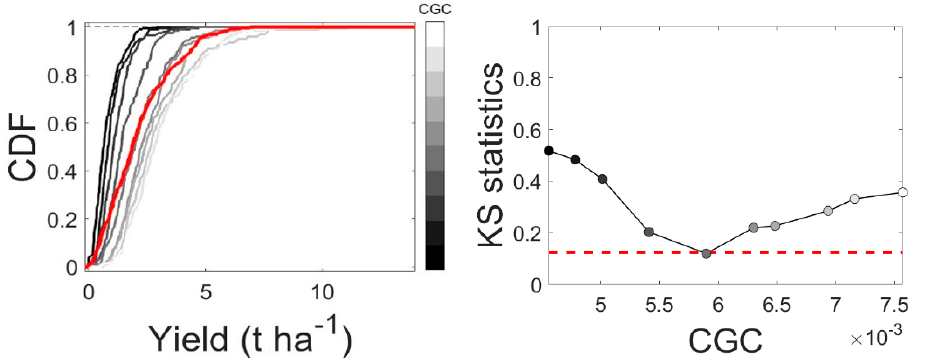
Figure 5. Cumulative Distribution Function (CDF) for the Canopy Growth Coefficient (CGC) parameter (left), red line on the left plot indicates the unconditional CDF and the grey colors represent the conditional CDF for ten different sampling points and Kolmogorov–Smirnov statistics (right), the red dashed line indicates the critical value of Kolmogorov-Smirnov (KS) statistics at 95% confidence interval.